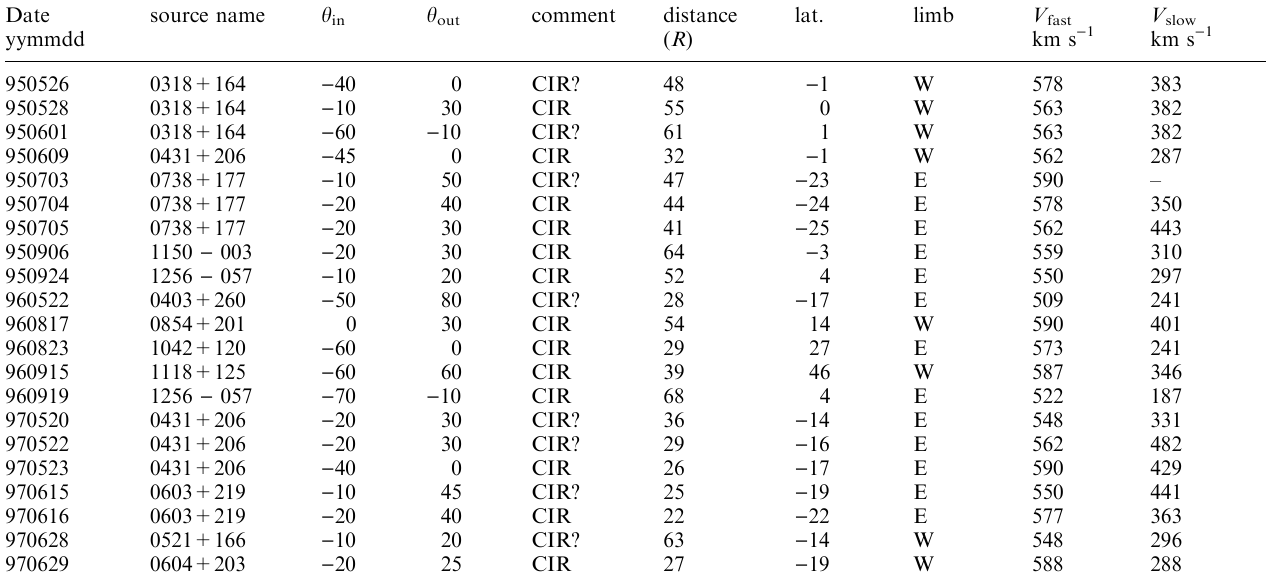
Table 2. Summary of 21 intermediate velocities observed between April 1995 and July 1997. These observations were made when the geometry of the IPS ray-path was likely to place a compression region within the field of view of the